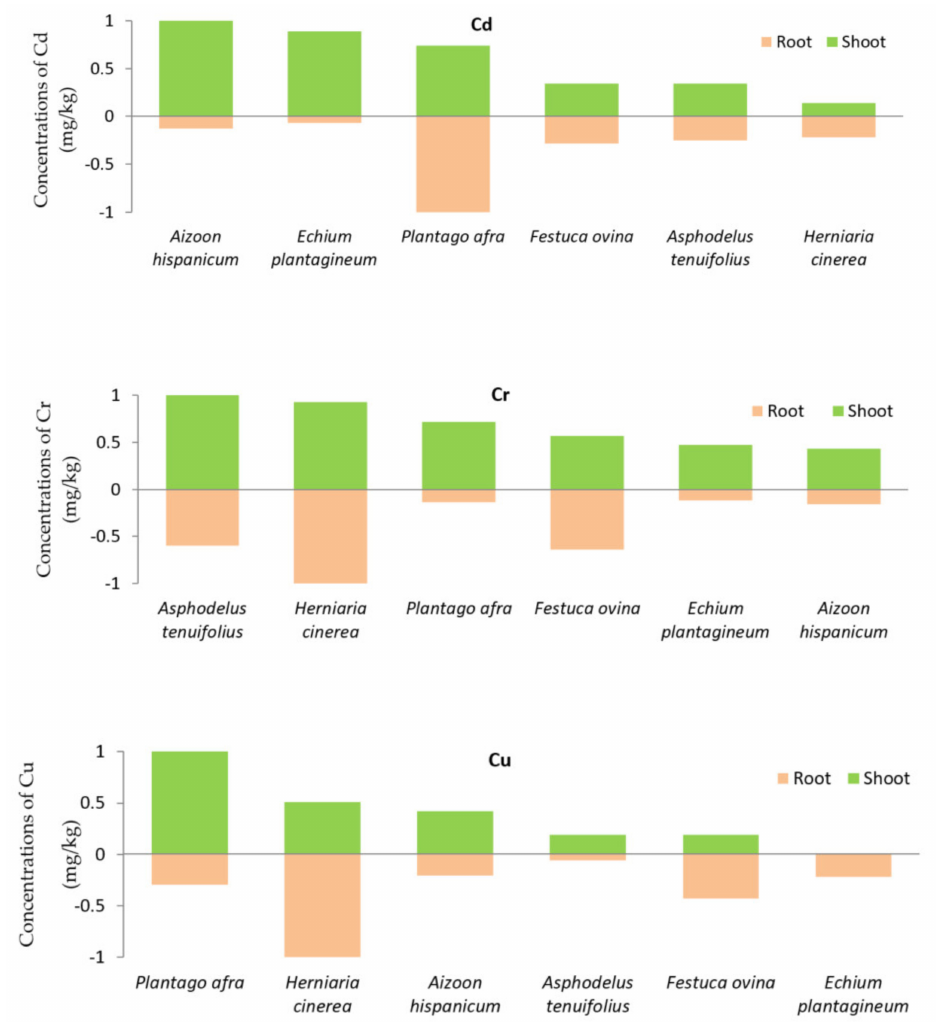
Figure 2. Candidate plants for the phytostabilization of phosphate wastes cover in increasing order of accumulation in shoots of Cd, Cr, and Cu metals. Root’s concentrations have been assigned negative values for plotting